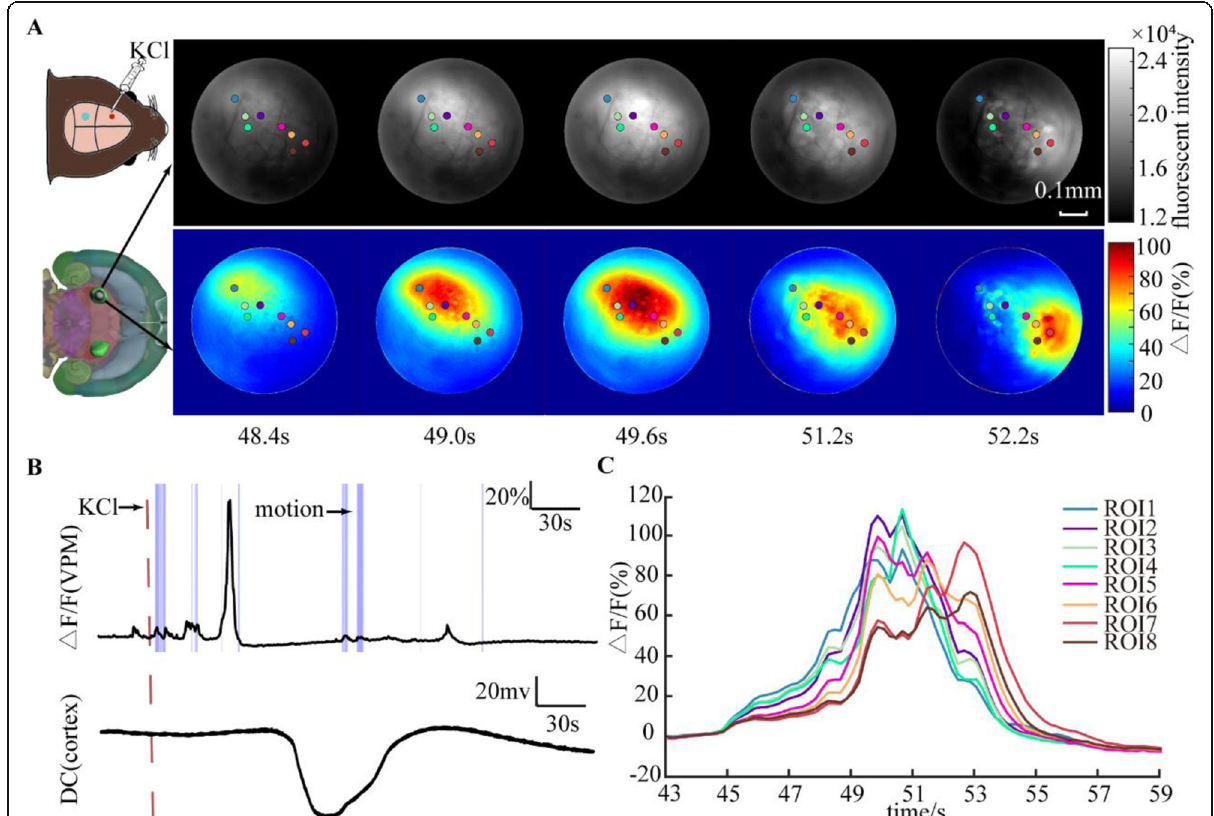
Fig. 3 Spatiotemporal evolution of CSD-related responses from the VPM in a single trial. A Fluorescence response evoked by one CSD. Eight ROIs were selected to analyse their temporal-spatial characteristics. The upper row showed the raw fluorescence intensity, and the lower row showed the relative fluorescence change. The response first arisesd at the upper left and ends at the lower right of the imaging field. B The fluorescence intensity changes of the VPM and the simultaneous DC shift in the cortex. Dashed line indicated the timing for adding KCl. The purple shaded areas indicated the movement of the mouse. The motion-related fluorescence change was relatively small compared to that of CSD. C The fluorescence intensity changes of the eight ROIs. The ROI located more posterior- lateral reached the maximum fluorescence intensity earlier than the other